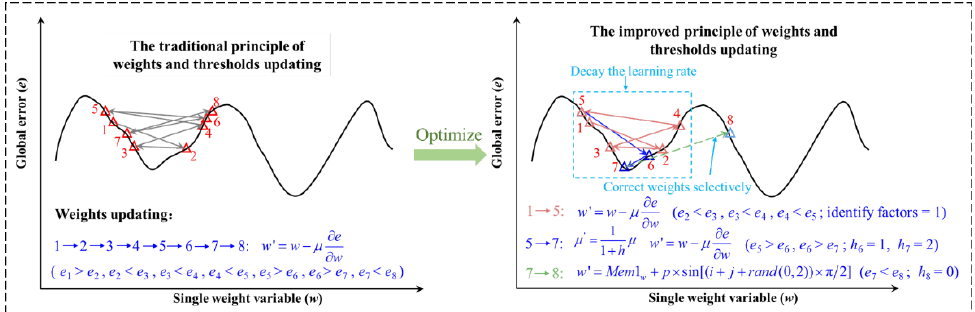
Figure 4. Comparison of the traditional and improved updating principle of the weights and thresholds.